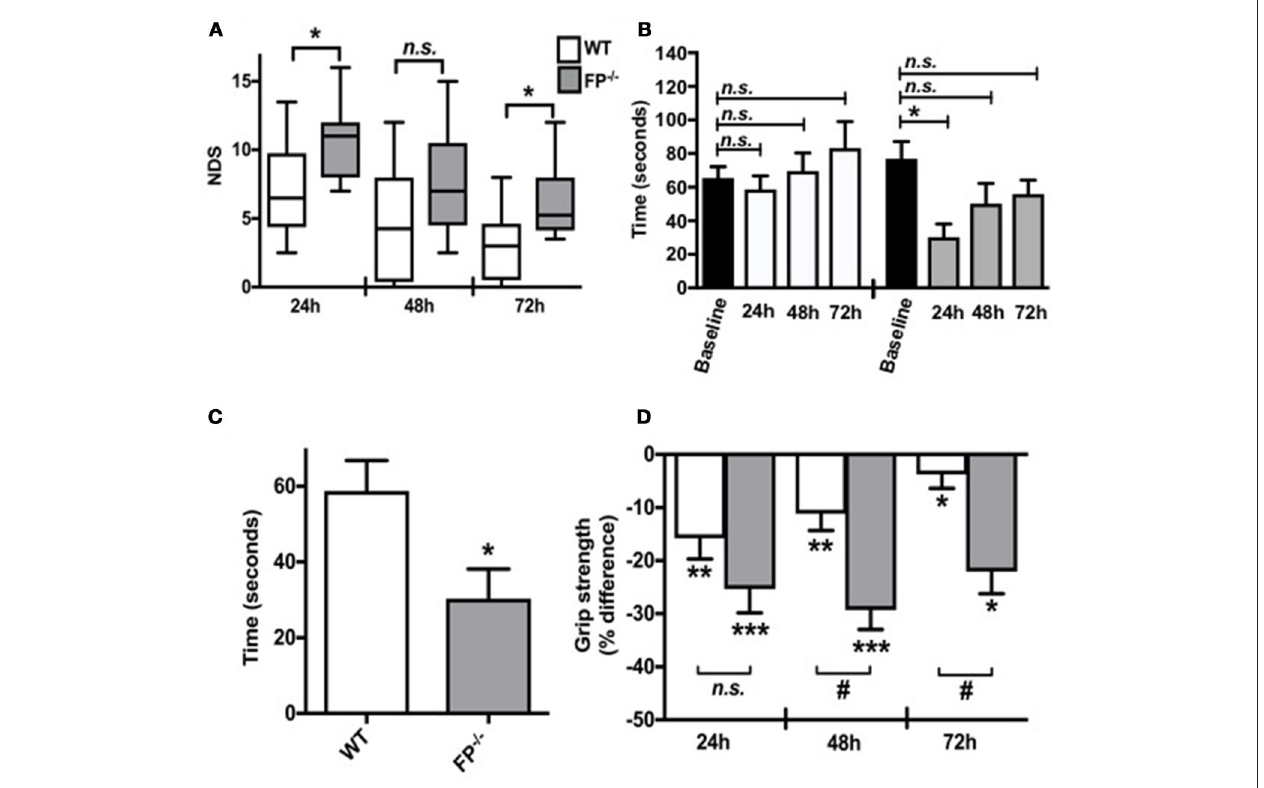
FIGURE 1 | Effect of PGF 2 α -FP receptor deletion on functional neurological outcomes after ICH. Neurobehavioral testing of WT and FP − / − mice was performed by investigators blinded to genotype at 24, 48, and 72h post-ICH. (A) At 24 and 72h post-ICH, FP − / − mice had significantly more neurological deficit scoring compared to WT mice, and recovery was seen in both FP − / − and WT mice. (B,C) WT and FP − / − mice had similar baseline rotarod performances. Only the FP − / − mice had significantly reduced latency to fall when compared to baseline function 24h post-ICH ( P < 0.05). The FP − / − also had a greater recovery time in returning to baseline; whereas, this comparison was not obvious for the WT mice. (D) Changes in grip strength in FP − / − and WT mice 24, 48, and 72h post-ICH was depicted on the bar graph. Both groups showed significant changes in grip strength at all times points; however, at 48 and 72h post-ICH FP − / − mice showed significantly greater deficits in grip strength compared to the WT mice ( P < 0.001). Both groups recovered, although the FP − / − mice recovery was slower than the WT mice. All comparisons included n = 7–10 WT and n = 11 FP − / − mice, and statistics were calculated using a two-way repeated measures analysis of variance with Newman–Keuls multiple comparisons test (NDS and rotarod) and a paired Student’s t -test versus baseline (grip strength). ns = not significant, * P < 0.05. ** P < 0.01. *** and # P < 0.001. FP = F prostanoid receptor subtype; WT =